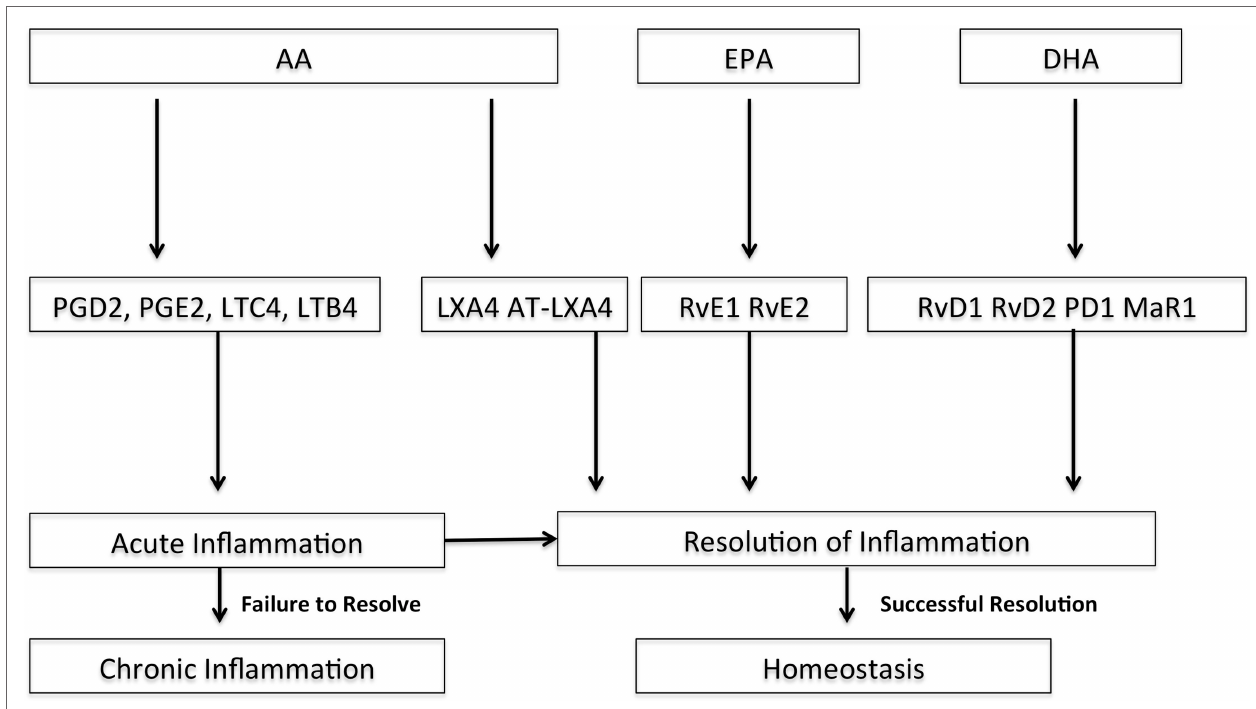
FiGURe 3 | Pathways of selected downstream lipid mediators derived from arachadonic acid (AA), docosahexaenoic acid (DHA), and eicosapentaenoic acid (ePA) for resolution of acute inflammation . DHA and EPA are ω -3 fatty acids. Adapted with permission from Serhan and Petasis (198); PGD2, prostaglandin D2; PGE2, prostaglandin E2; LTC4, leukotriene C4; LTB4, leukotriene B4; LXA4, lipoxin A4; AT-LXA4, aspirin-triggered lipoxin A4; RvE1, resolvin E1; RvE2, resolvin E2; RvD1, resolvin D1, RvD2, resolvin D2; PD1, protectin D1; MaR1, maresin